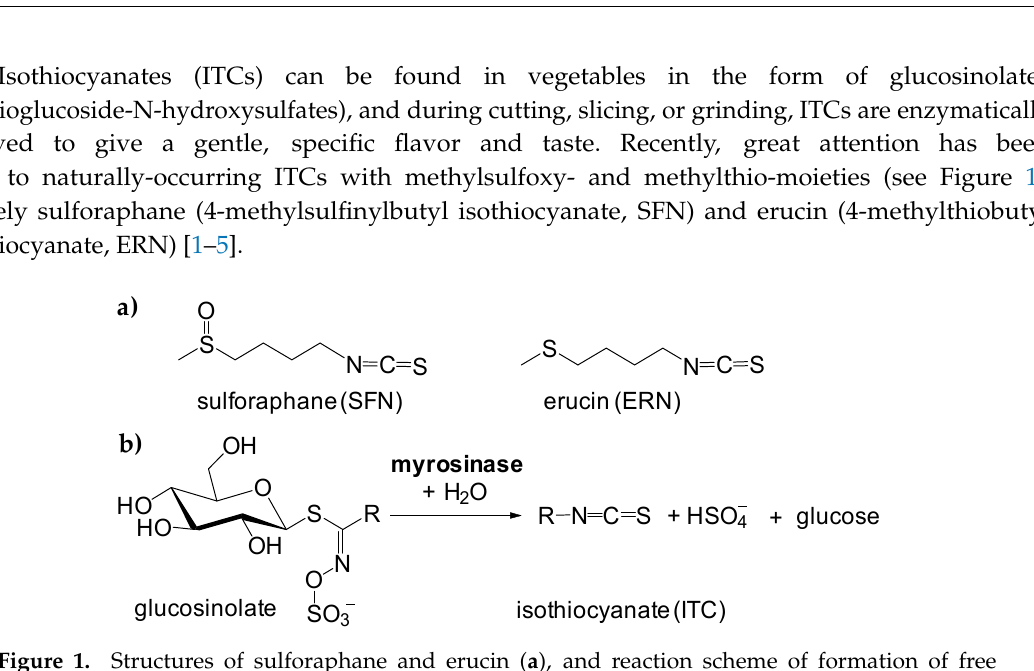
Figure 1. Structures of sulforaphane and erucin ( a ), and reaction scheme of formation of free isothiocyanates (ITCs) during hydrolysis of glucosinolates in the presence of myrosinase ( b ). Both ITCs are the components of our diet when consuming common Cruciferous vegetables [1,6]: SFN is present in broccoli, some cultivars of cabbage, and Brussels sprouts while ERN predominantly could be obtained from rocket [1,6–8]. Certain amounts of SFN along with ERN, could be provided from cabbage and red cabbage, rutabaga or turnip